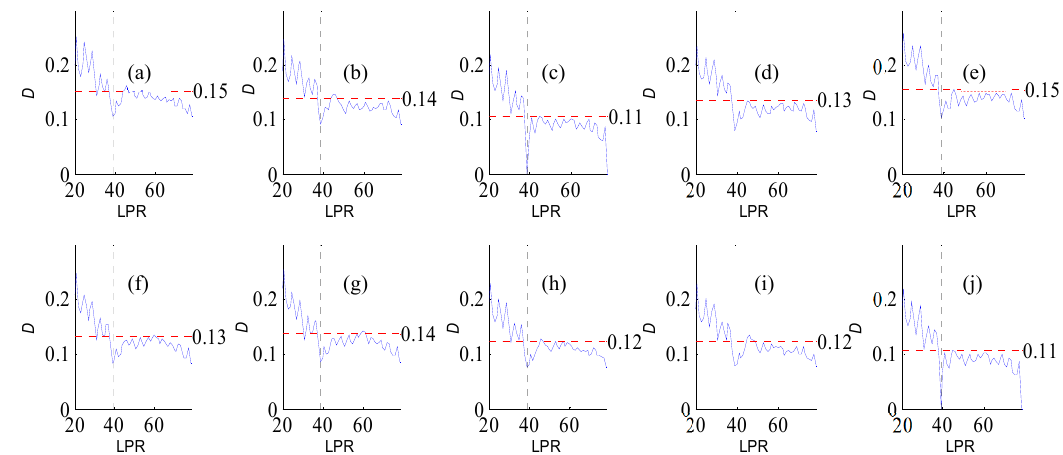
Figure A28. Variation of flow regime alteration degree (D) measured by the RVA with change in the length of post-impact flow time series (LPR) under a periodicity of 38 years. ( a ), ( b ), ( c ), ( d ), ( e ), ( f ), ( g ), ( h ), ( i ), and ( j ) correspond to pre-impact flow time series length = 27, 33, 38, 43, 49, 54, 60, 65, 71, and 76 years, respectively. The abscissa value for the vertical dotted line is 39. The ordinate value for the horizontal dotted line is the mean degree of flow regime alteration in each subfigure.